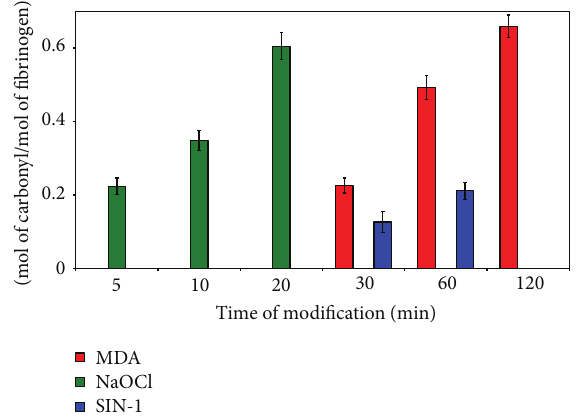
Figure 1: Evaluation of carbonyl groups in modified fibrinogen. Fibrinogen was treated with MDA, NaOCl, and SIN-1. Content of carbonyls was determined by DNPH derivatization [15]. Data are represented as mean ± SD from five independent